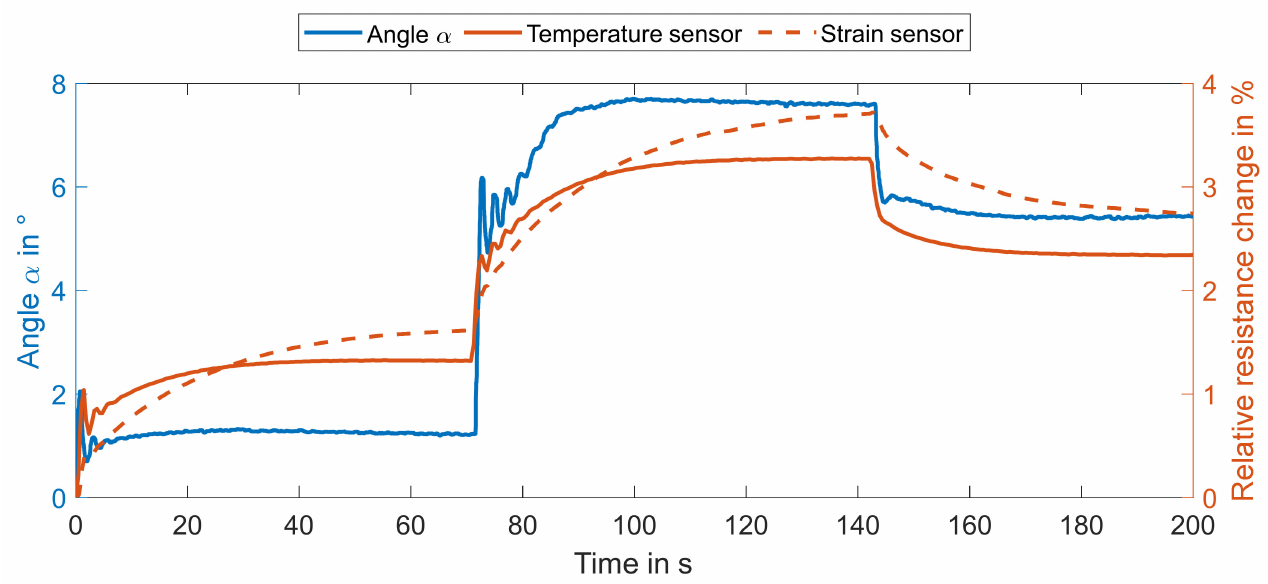
Figure 7. Deformation and signals of temperature and strain sensors 2 during the control experiments for activation of SMA wire 2 based on a PID